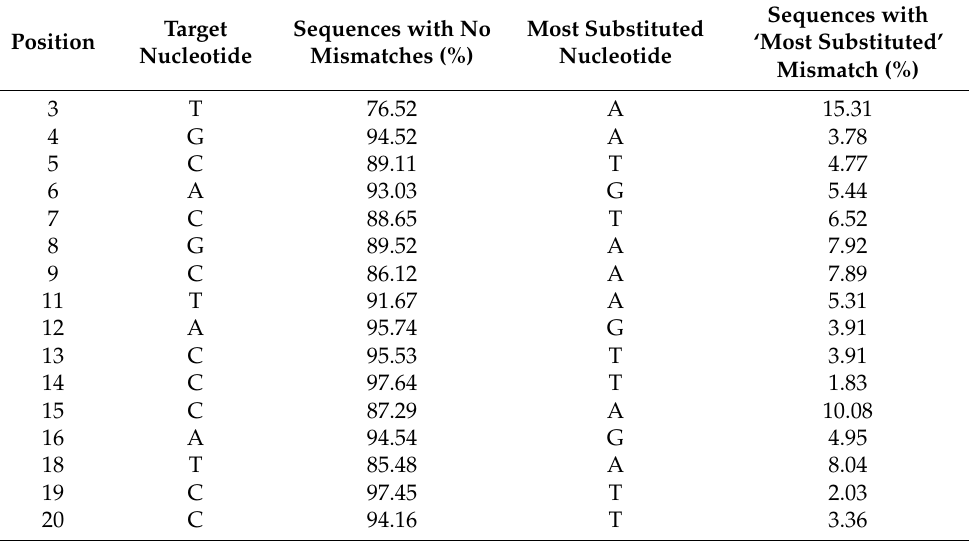
Table 2. Least mismatch-tolerant position–nucleotide pairs weighted by experimental read count (also referred to as the experimental cleavage